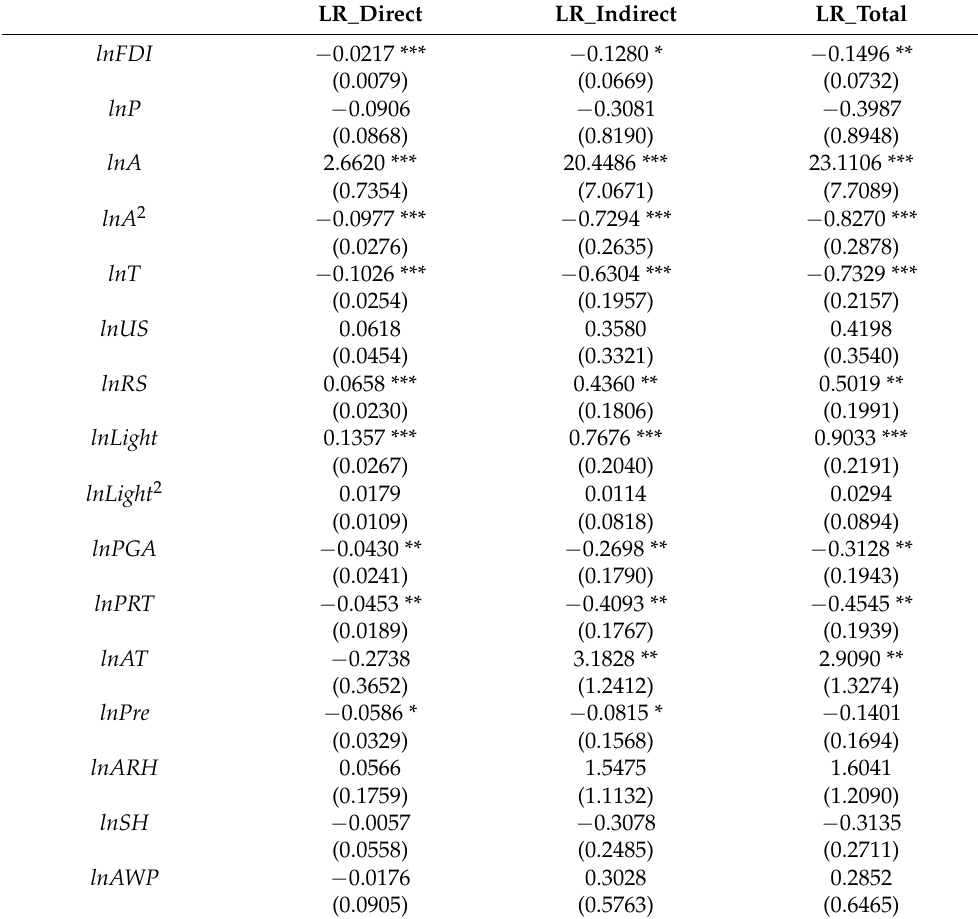
Table 5. Decomposition of effects in the dynamic SDM